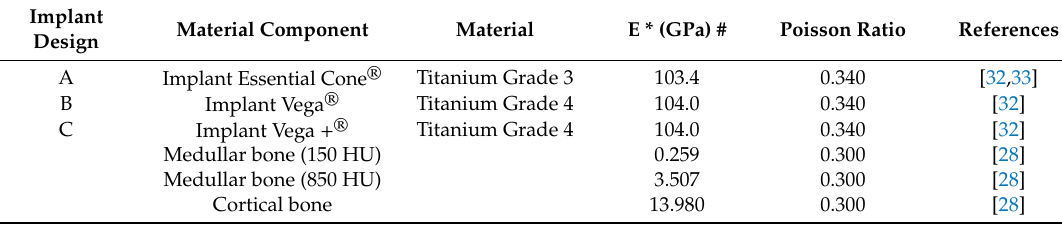
Table 1. Material properties used in finite element